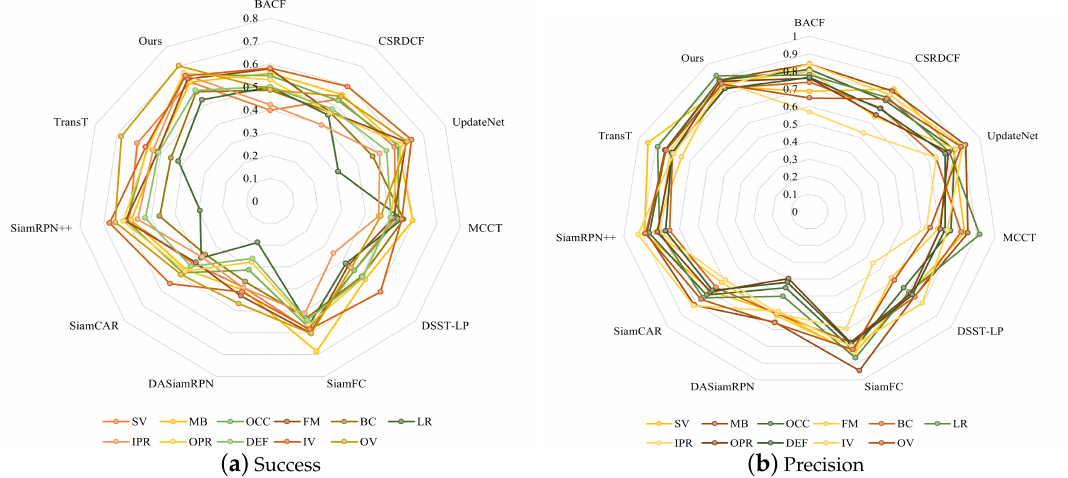
Figure 8. The proposed method compared with trackers on